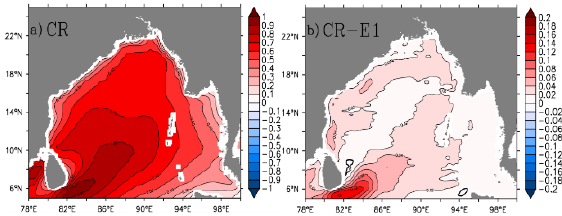
Figure 1. Magnitude of time-mean surface wind stress (dyn/cm2) of (a) CR and differences in the magnitude of the time-mean between (b) CR and E1 for the year 2015